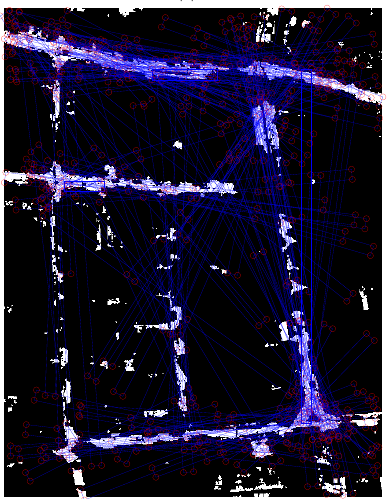
Figure 9. Final population from differential evolution